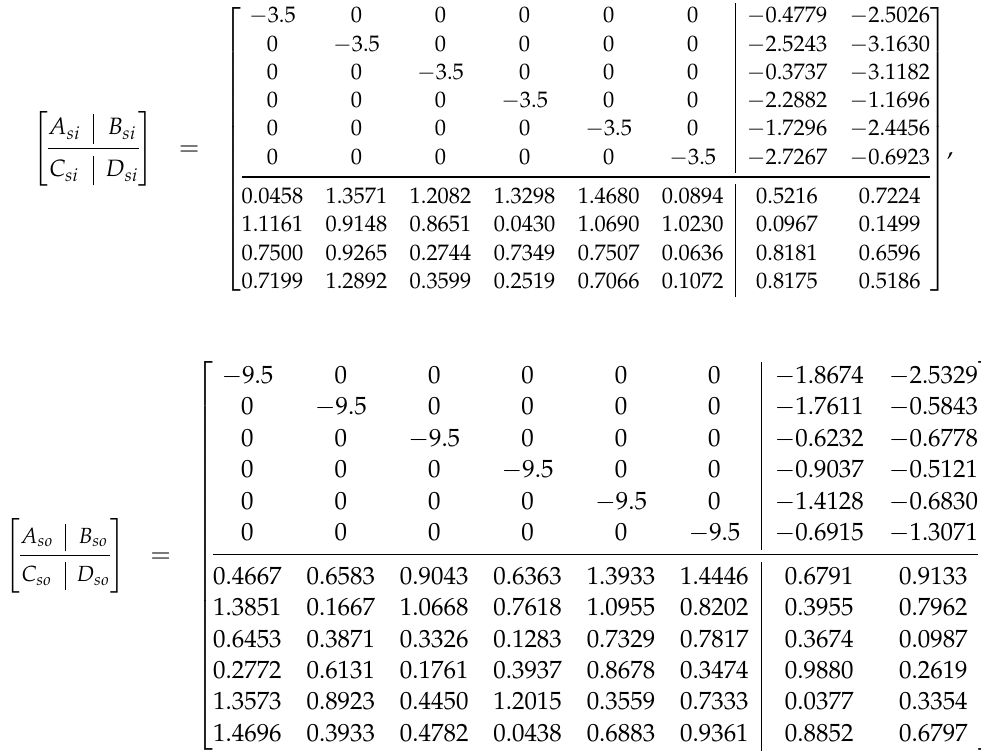
Table 2 give a comparison for the frequency-response error and error bound are ROMs current models of 1st to 5th order obtained by using [50,51] and proposed technique. Pole-locations of ROMs obtained from Enns’s technique [48] and proposed technique are given in Table 3, it can be observed that Enns [48] gives unstable 3rd, 4th and 5th order ROMs with pole- location at s = 0.0001, − 0.0017, − 0.0023 , s = 1.5561 e − 3 ± 9.8696 e 4 i , − 0.0017, − 0.0017 and s = 1.5561 e − 3 ± 9.8696 e + 04 i , − 87.4326, − 0.0017, − 0.0017 respectively. However, the proposed technique yields stable 1st, 2nd, 3rd, 4th and 5th order ROMs with pole-location at s = − 0.0019 , s = − 0.0022 ± 0.0004 i, s = − 0.0017, − 1.5561 e − 3 ± 9.8696 e 4 i, s = − 1.7761 e − 3 ± 9.9879 e 4 i , − 0.0017, − 0.0017 and s = − 1.7761 e − 3 ± 9.9879 e 4 i , − 87.4326, − 0.0017, − 0.0017